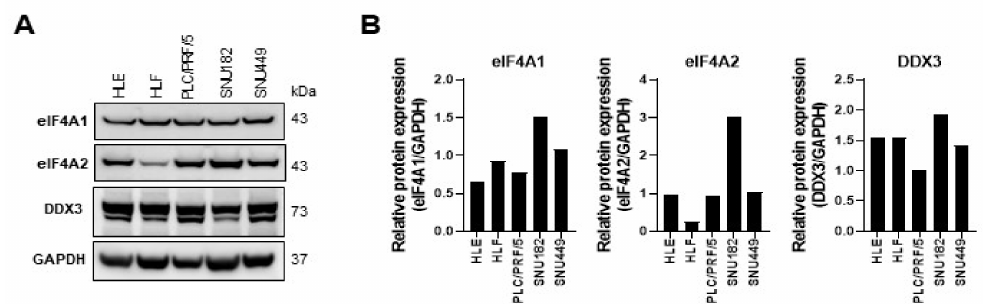
Figure 5. Human hepatocellular carcinoma cell lines express eIF4A1, eIF4A2, and DDX3 proteins. ( A ) The levels of the three proteins were assessed in HLE, HLF, PLF/PRF/5, SNU182, and SNU449 cell lines by western blot analysis. GAPDH was used as a loading control, and protein band intensities of eIF4A1, eIF4A2, and DDX3 were normalized to GAPDH levels ( B ).